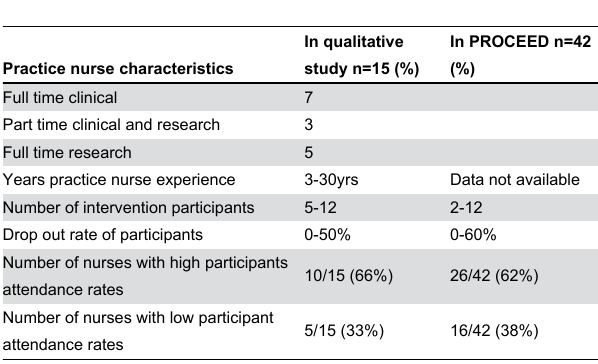
Table 1. Practice nurse